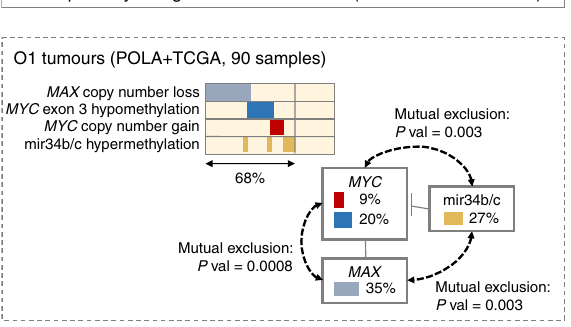
Figure 6 | Focus on O1 tumours and their specific MYC signalling related alterations. Percentages refer to the proportion of O1 tumours (pooled data from POLA and TCGA) harbouring the alterations. P values refer to one-sided binomial tests, which assess the probability that two of the three genetic loci are both altered in the same tumour sample.